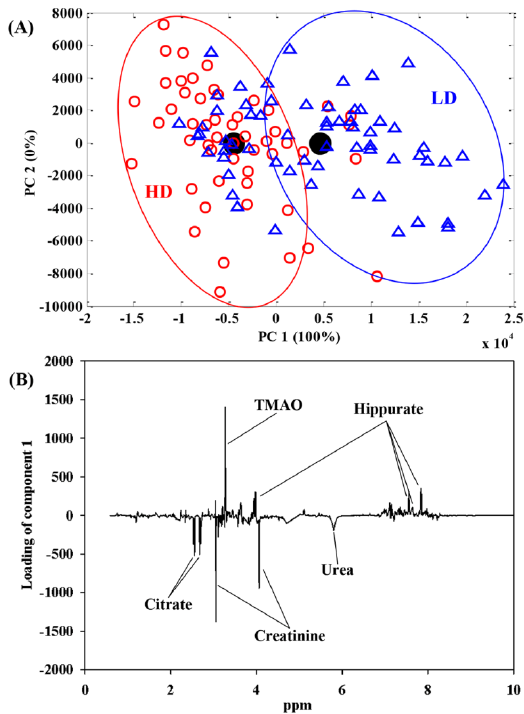
Figure 1. ASCA score ( A ) and loading ( B ) plots of the diet effect from NMR ‐ based urine metabolomics in overweight/obese women who consumed the high and low dairy products. In the score plot, the scores of each sample are also included. Assignments: citrate (2.54 and 2.68 ppm); creatinine (3.05 and 4.06 ppm); TMAO (3.27 ppm); hippurate (3.97, 7.55, 7.64 and 7.84 ppm); urea (5.80 ppm).